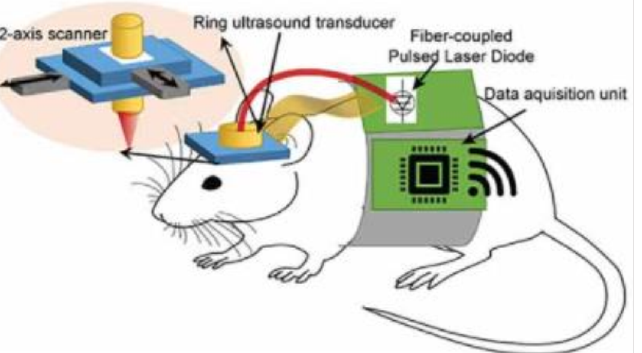
Figure 3. Illustration of a wearable PAM for mouse brain imaging (Reprinted with permission from Ref. [52]. 2020,